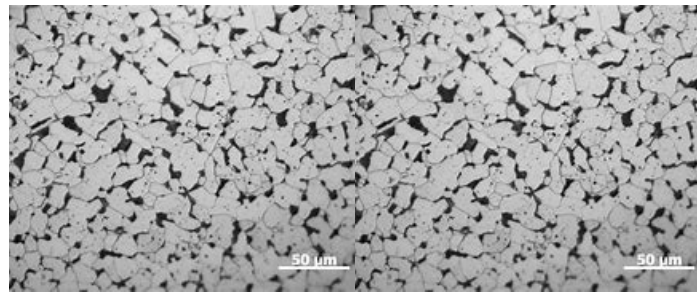
Figure 13. Metallography of 20# shell before the experiment.